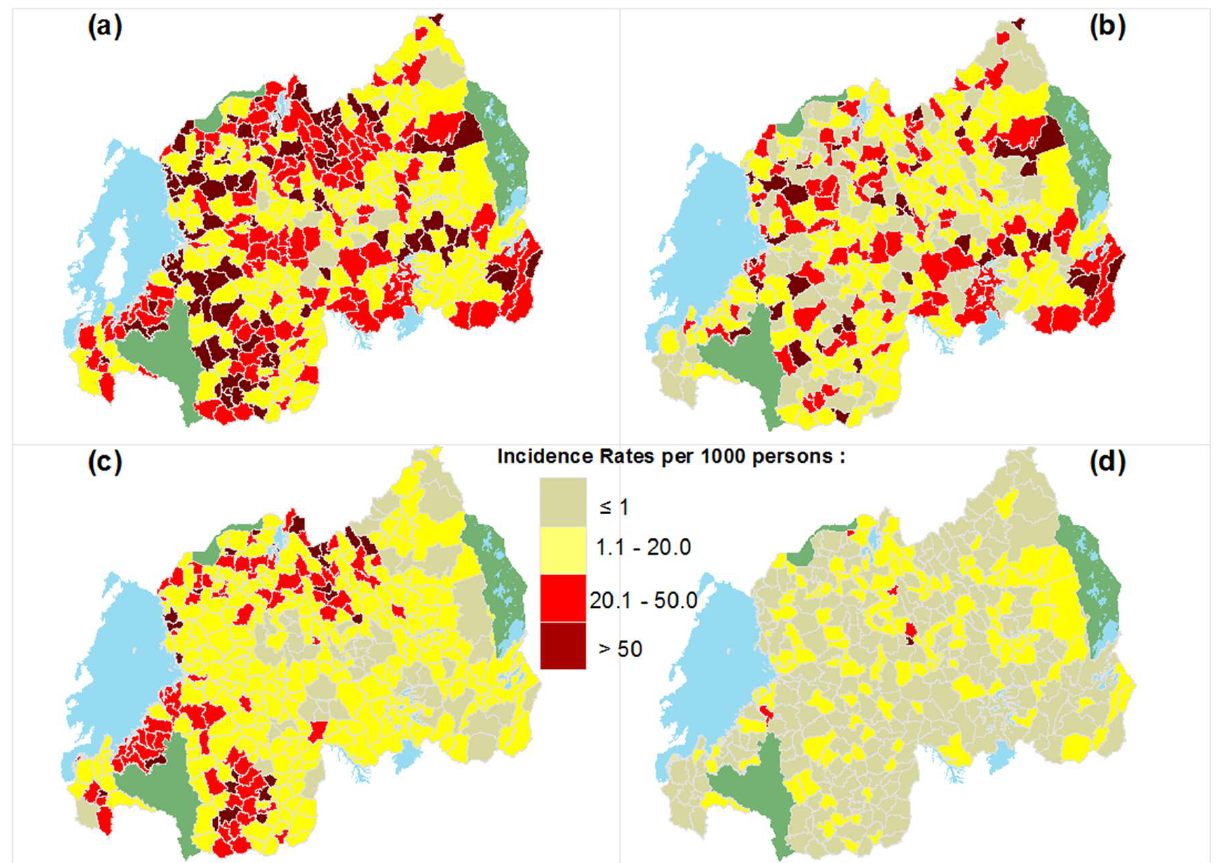
Figure 4. Incidence rates at HFSA level for combined STH infection ( a ), T. trichiura ( b ), A. lumbri- ( c ) and hookworm ( d ). coides ( c ) and hookworm ( d ).